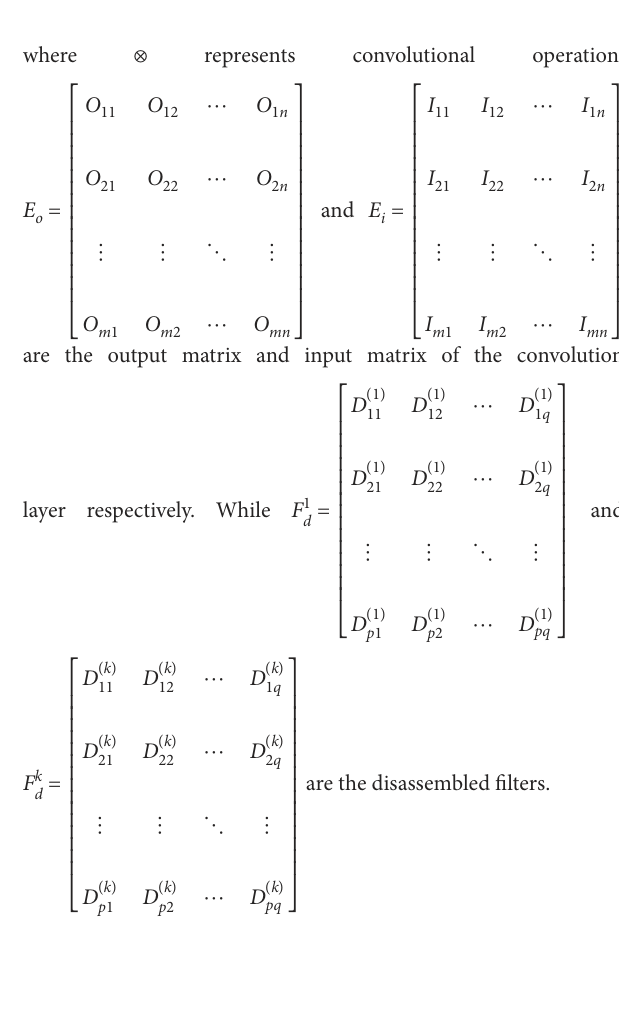
network for a maximum of 100 epochs and set the action of delaying the learning rates uniformly across the network by 50 percent per epoch when there are 5 epochs and the performance of the past model still does not improve, that is η ( T )